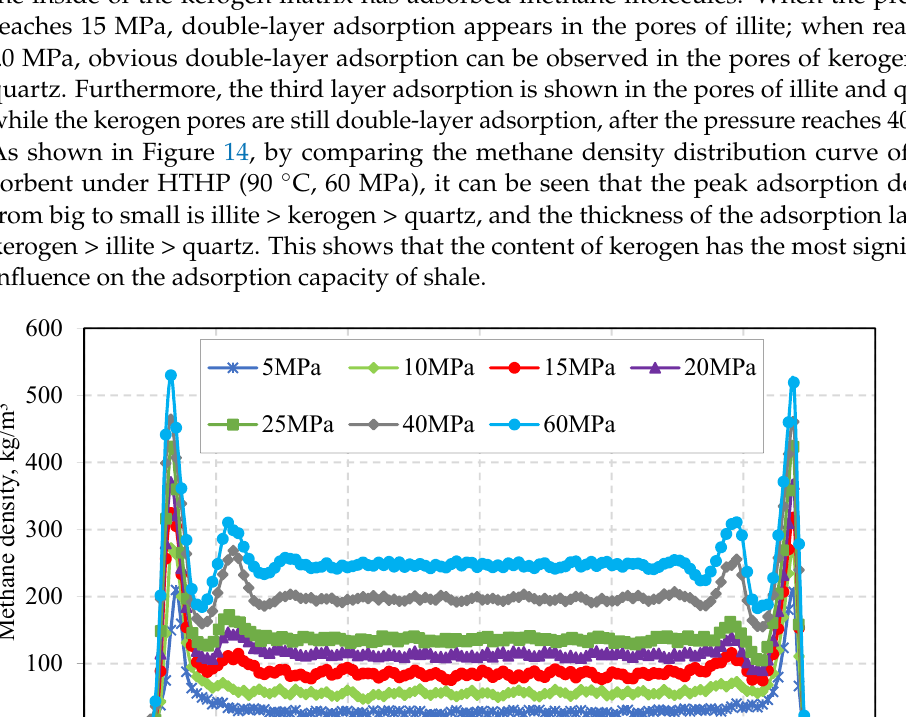
Figure 13. Methane density distribution curve in quartz slit-shaped pore space (including pore walls). Figure 14. Methane density distribution curve in different matrix pores.